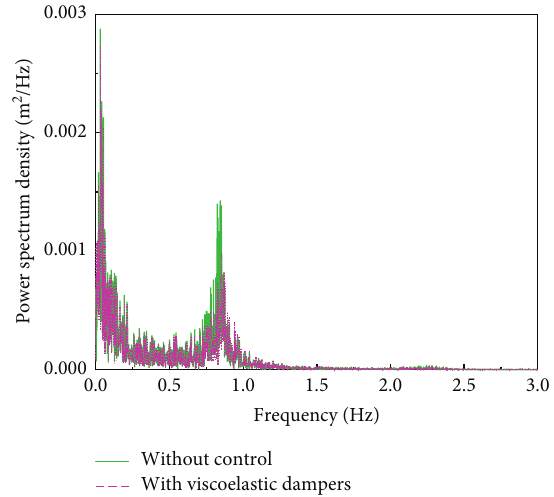
Figure 17: Power spectrum density of the displacement